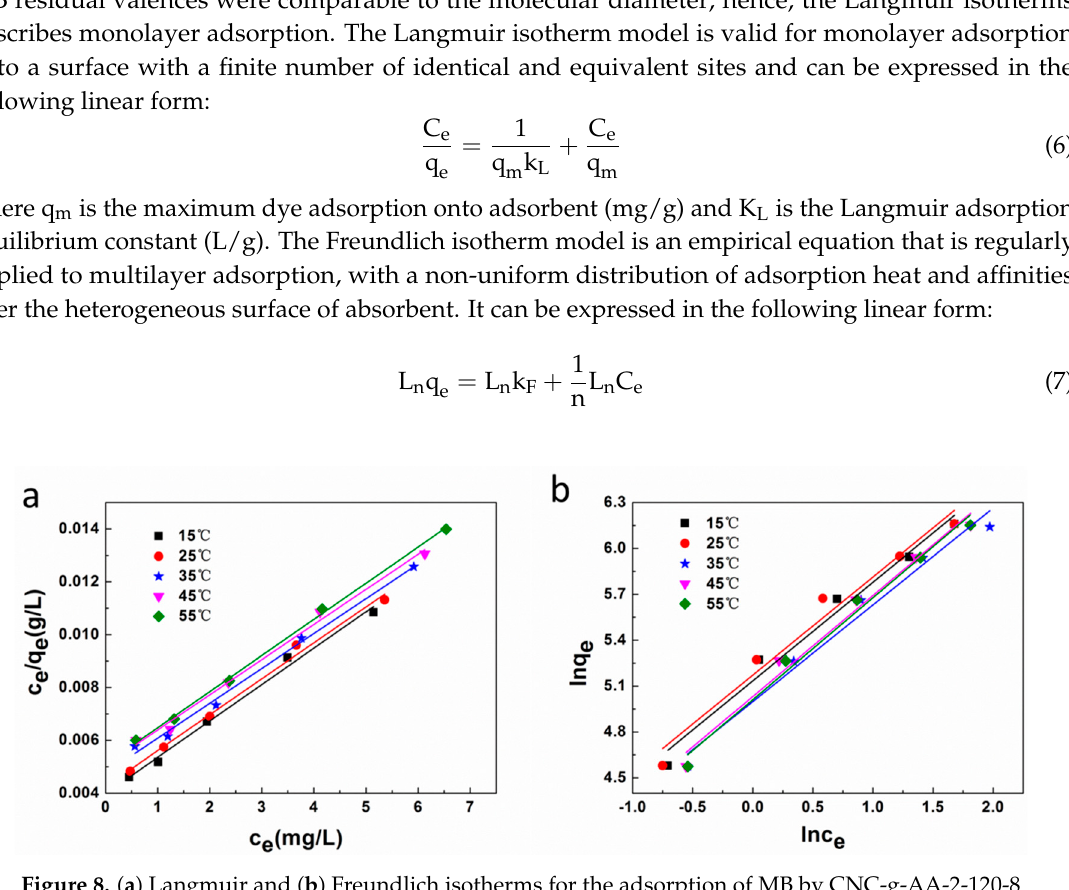
Figure 7. ( a ) Lagergren-first-order kinetic model, ( b ) pseudo-second-order kinetic model and ( c ) intra-particle diffusion model for adsorption of MB onto CNC-g-AA-2-120-8 aerogels at 25 °C.